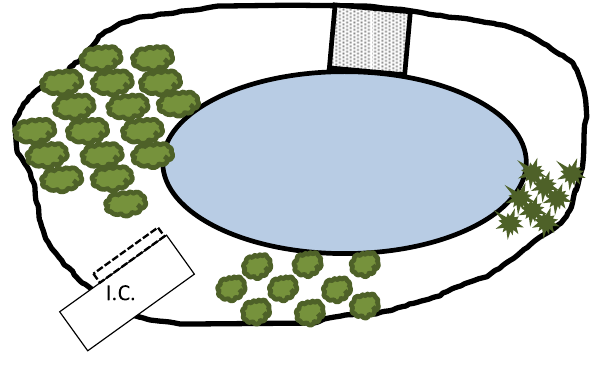
FIG. 3. School yard with an impassable